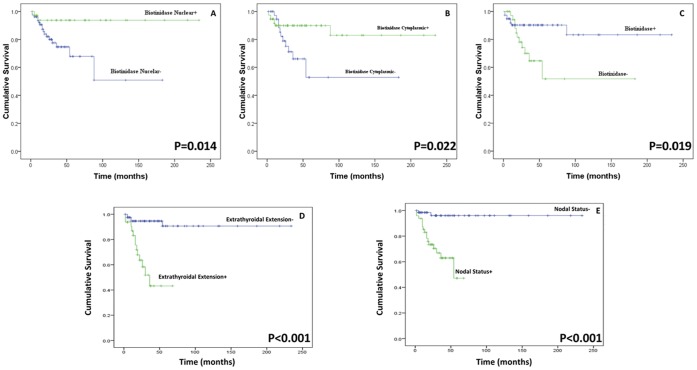
Kaplan–Meier estimation of cumulative proportion of disease-free survival in thyroid cancer patients.Disease free survival curves showing biotinidase expression in (a) nucleus [median disease-free survival 116 months]; (b) cytoplasm [median disease-free survival 111 months]; (c) and overall (nucleus and cytoplasm) [median disease-free survival 109 months]. Disease free survival curves showing (d) extrathyroidal extension [median disease-free survival 36 months], and (e) nodal status [median disease-free survival 54 months].